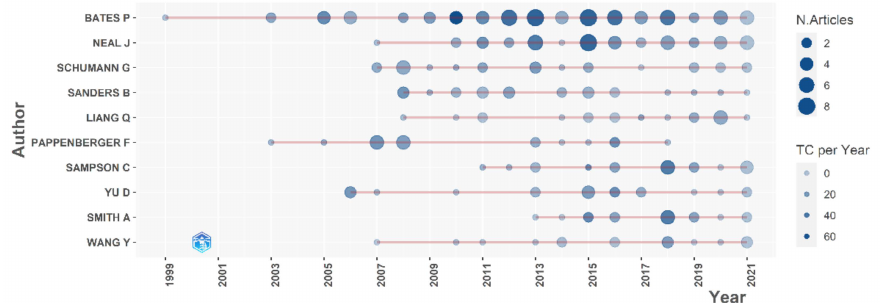
Figure 7. Top-Authors’ Production over time. Number (N) of articles y Totals Cites (TC) per